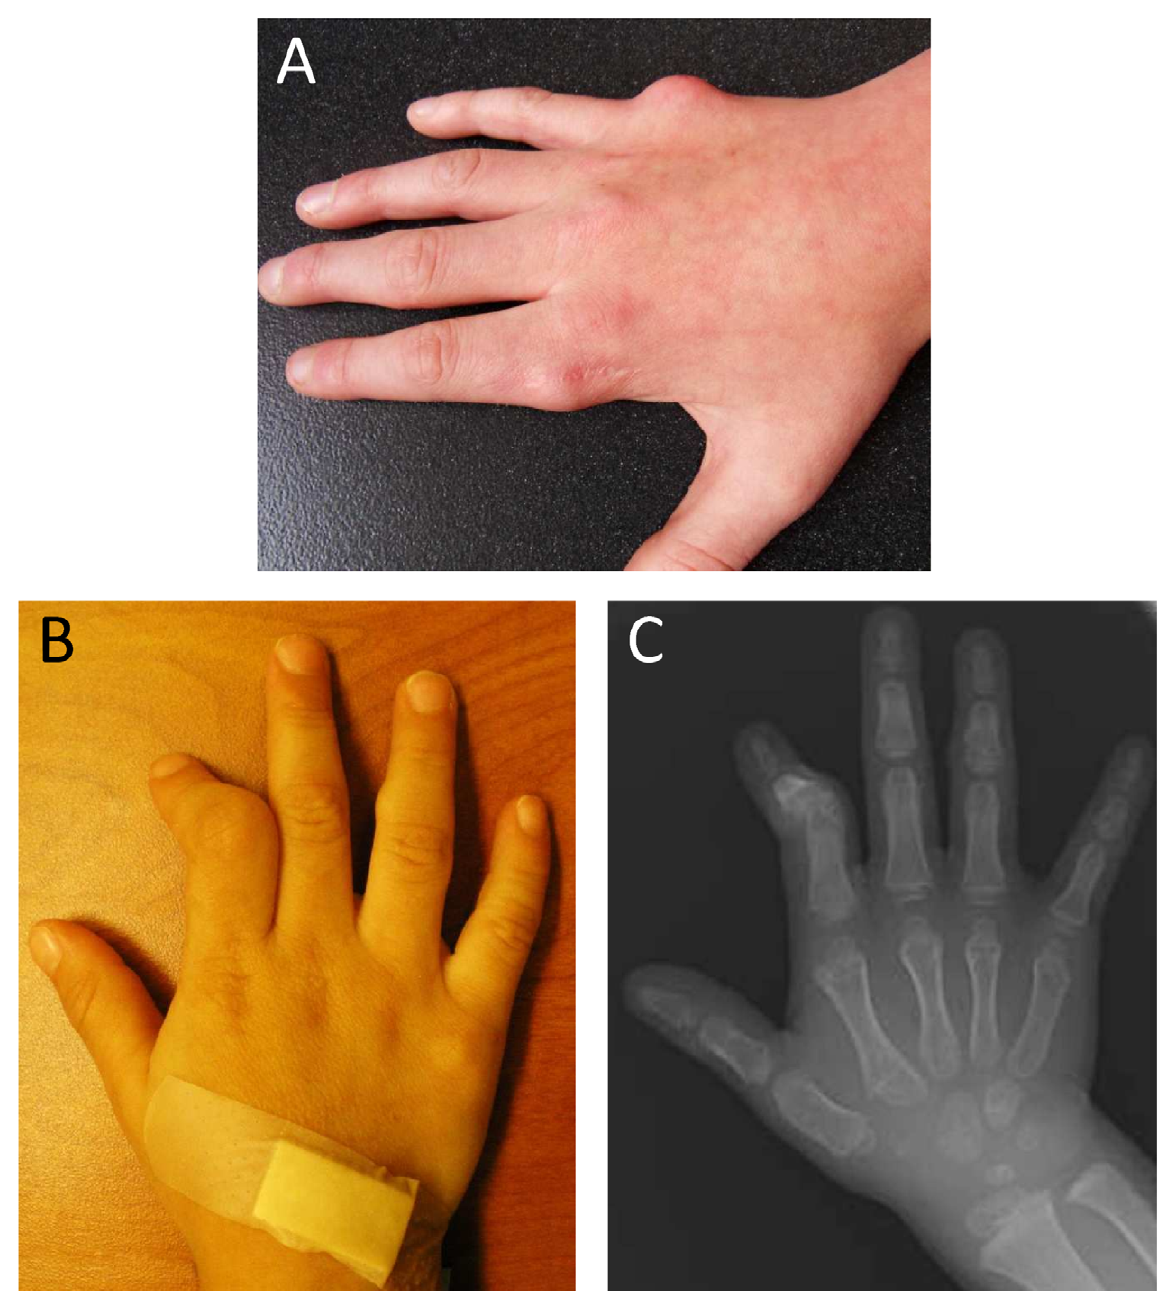
Figure 1. Manifestations of metachondromatosis. (A) Dorsal view of the right hand of individual III-2 in Pedigree 2 at age 12 years, with residual exostoses following partial surgical removal over the metacarpophalangeal (MCP) joint of the second digit and primary exostoses of MCP of the fifth digit. (B) Dorsal view of the right hand of individual V-1 in Pedigree 1 at three years, showing deformity of the second digit secondary to exostoses of the middle phalanx and an exostoses over the middle phalanx of the fourth digit. (C) Radiograph of the dorsal view of the right hand of individual V-1 in Pedigree 1 at three years.